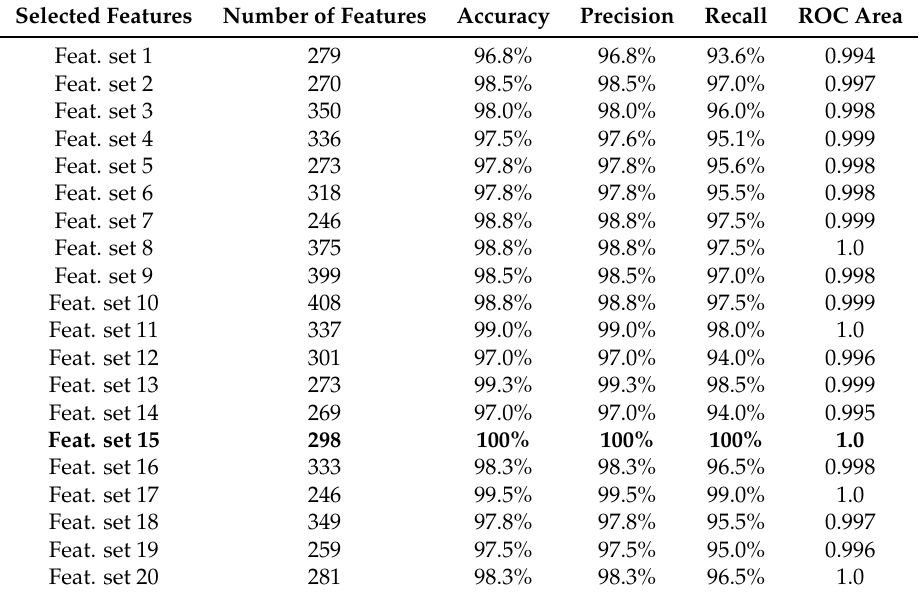
Table 5. Detection of normal or abnormal using BGWO with the fusion of curvelet and wavelet features. Selected Features Number of Features Accuracy